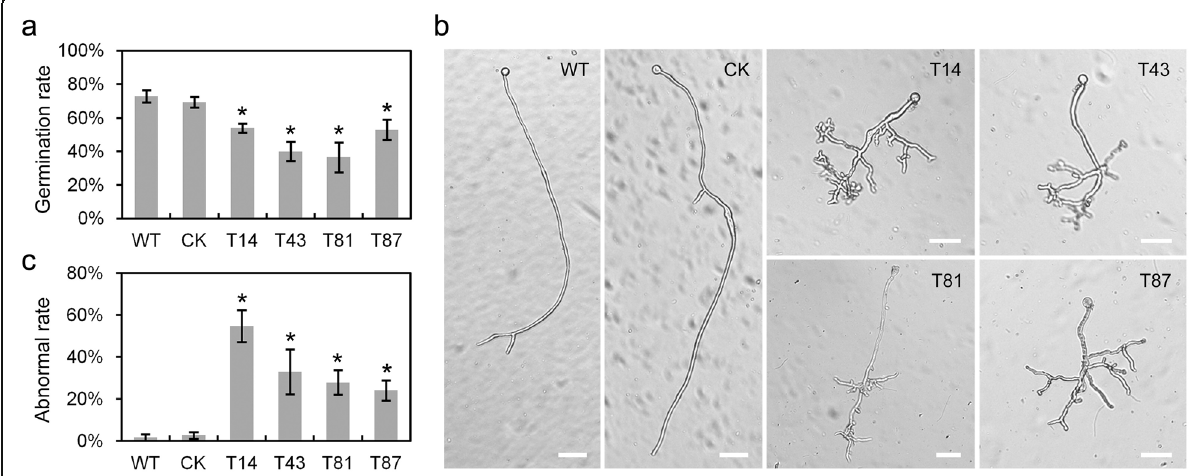
Fig. 2 Cyst germination was affected in PsBZP32 -silenced transformants. a Cyst germination rate at 3 h after encystment. b Microscopic observation of germinated cysts at 10 h after encystment. Representative normally germinated hypha of WT and CK, and abnormally germinated hypha (short with multiple branches) of PsBZP32 -silenced transformants are shown. c Abnormal rate of germinated cysts at 10 h after encystment. Bar, 20 μ m. *, significant difference compared with the WT (two-tailed t -test, P < 0.01)